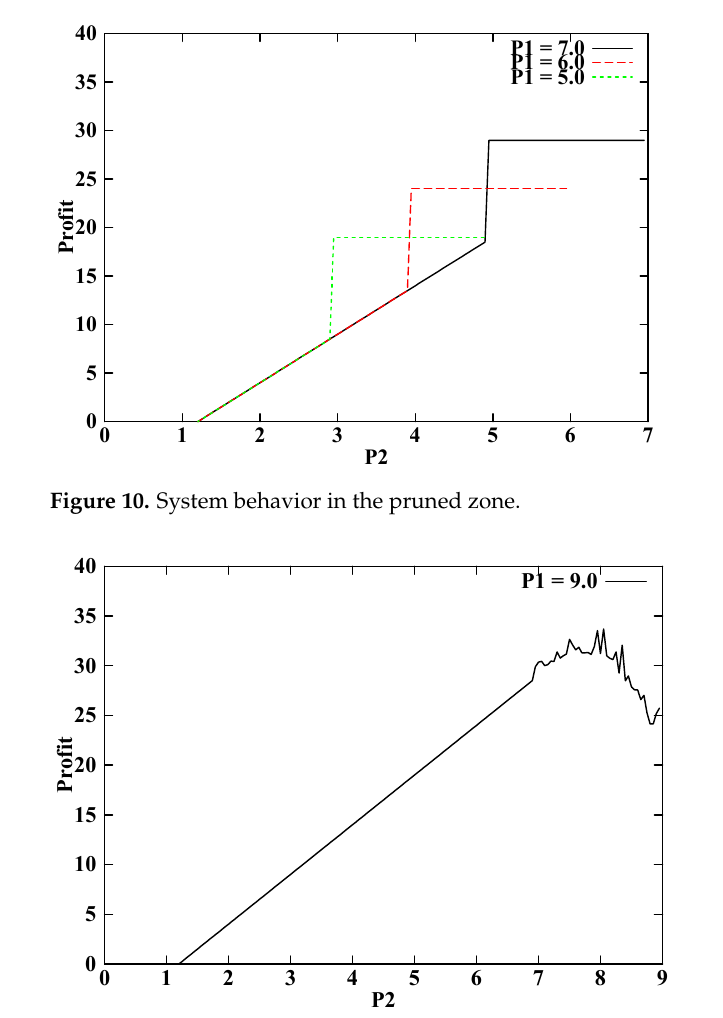
Figure 11. System behavior in the not-pruned zone.